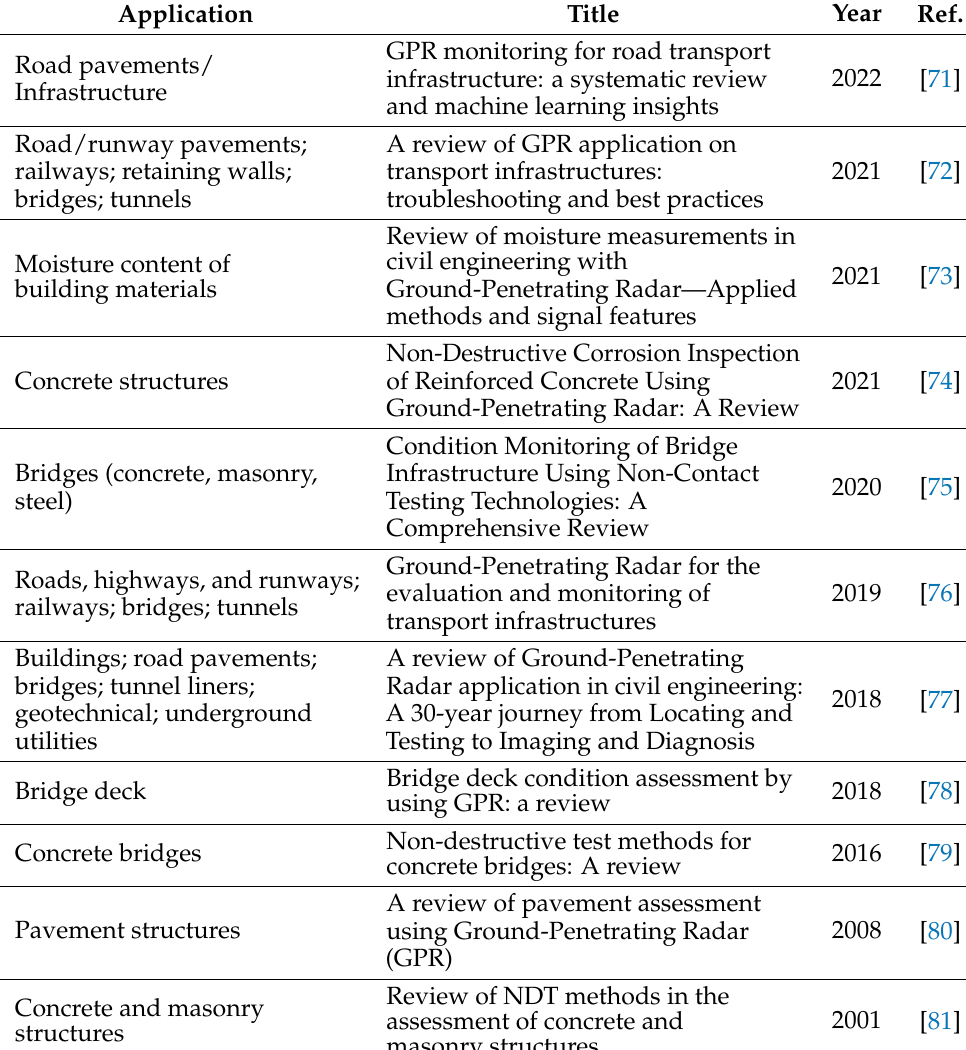
Table 1. Published review papers in civil engineering